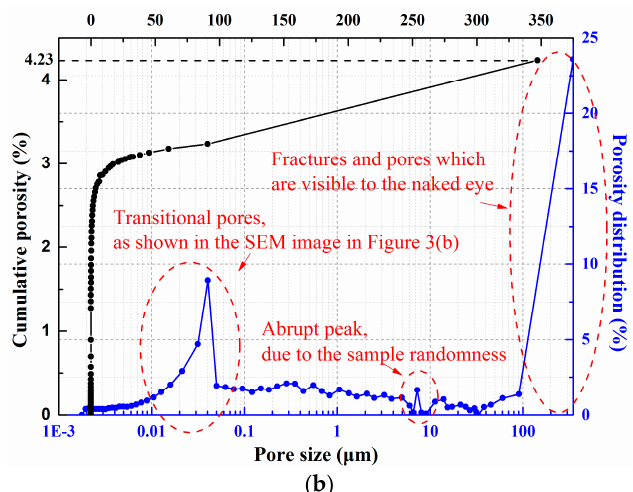
Figure 8. Results of pore space characterization using MIP and low temperature nitrogen adsorption: ( a ) pore volume and ( b ) porosity in the coal matrix.